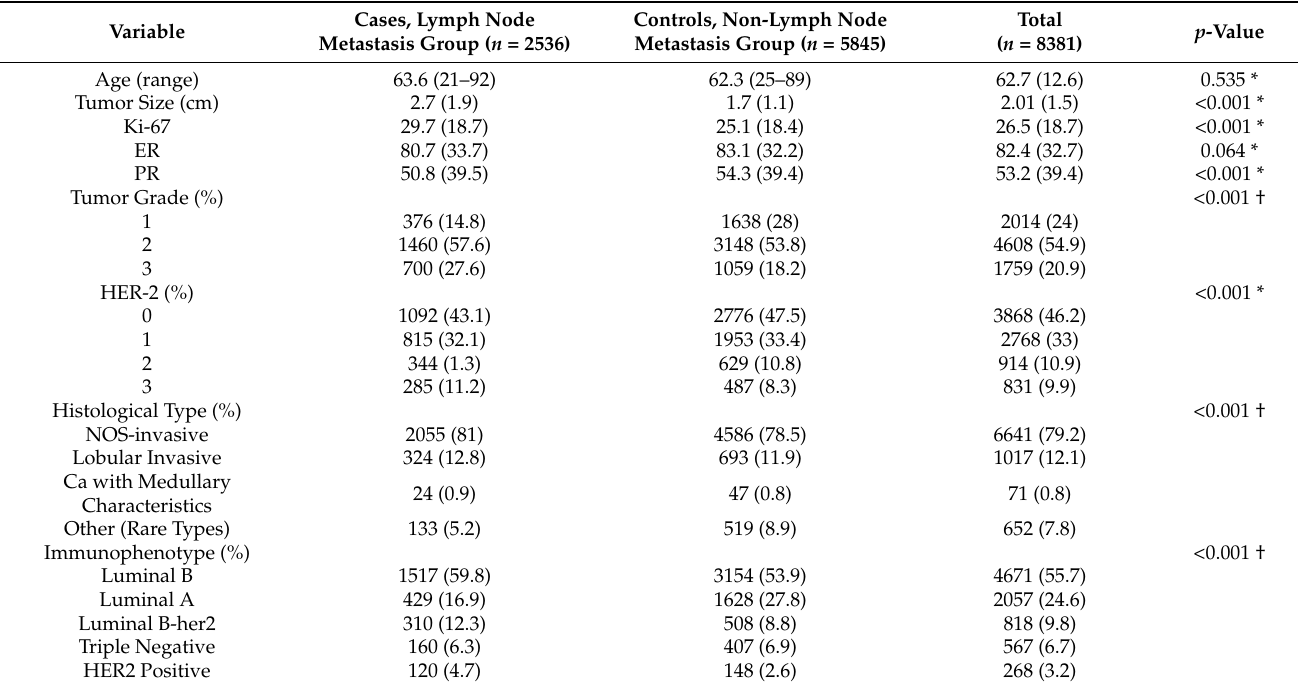
Table 1. Patient characteristics (total population case/control comparison).